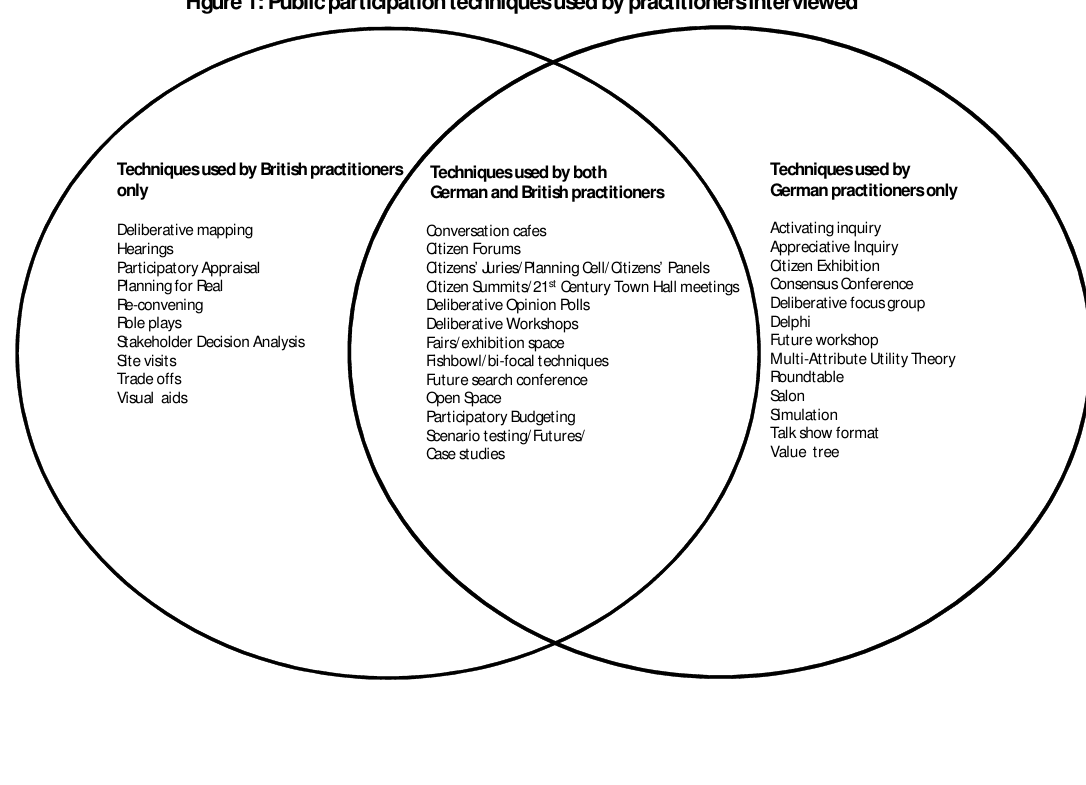
Figure 1: Public participation techniques used by practitioners